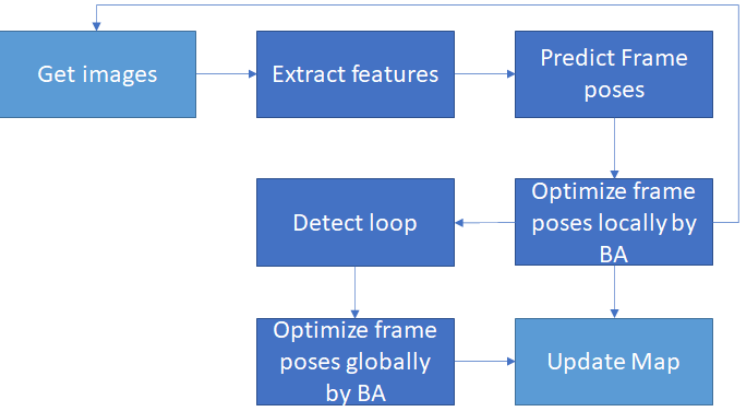
Figure 4. ORB-SLAM series structure.